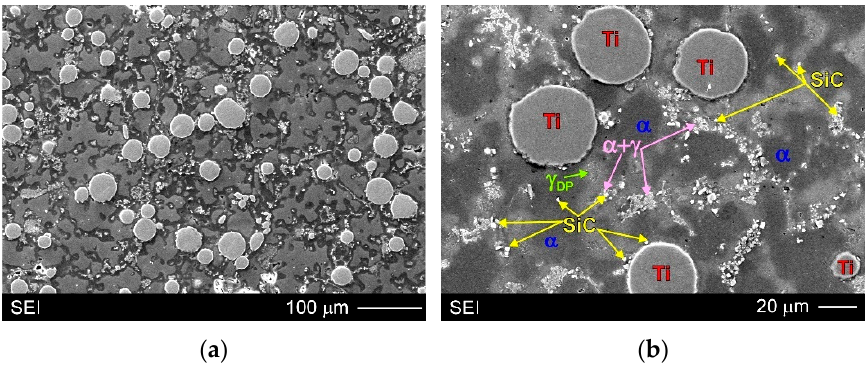
Figure 6. Microstructure of AZ91/(SiC + Ti) p hybrid composite: ( a , b ) SEM micrographs taken at different magnifications of various areas of etched surface.